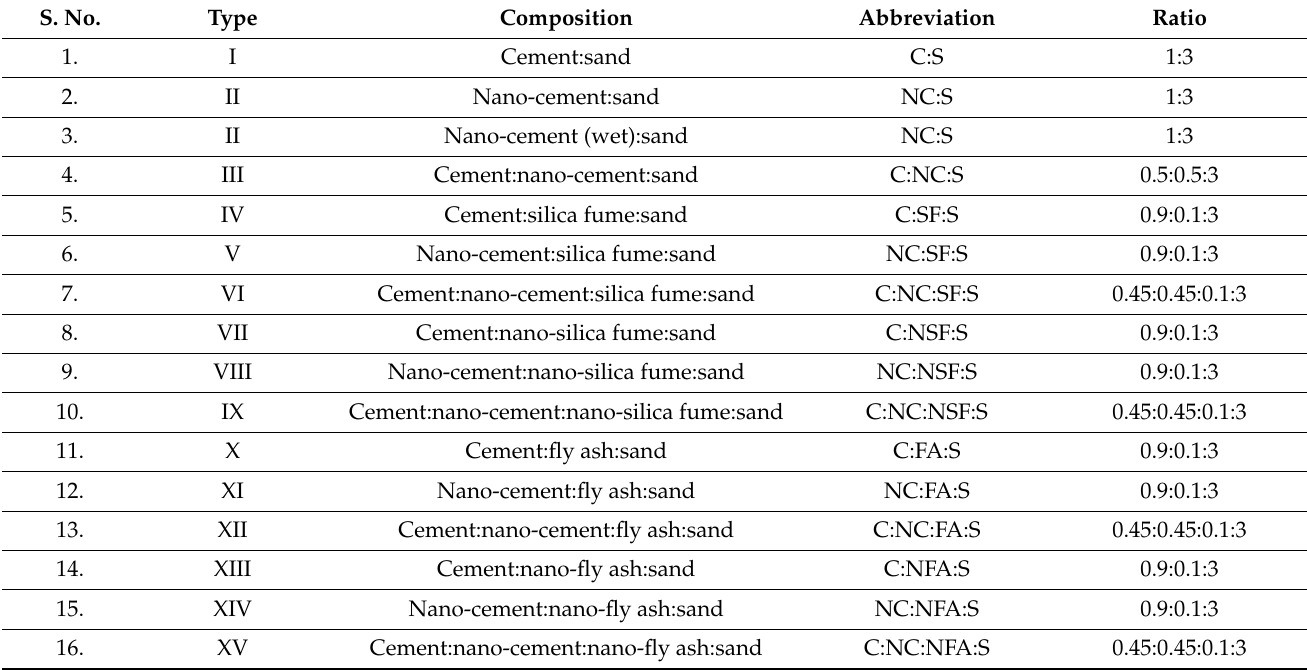
Table 7. Comparison of test results of cubes with cement (C) and nano-cement (NC) with test results of cubes with cement, nano-cement, and silica fume (SF); test results of cubes with cement, nano- cement, and nano-silica fume (NSF); test results of cubes with cement, nano-cement, and fly ash (FA); test results of cubes with cement, nano-cement, and nano-fly ash (NFA); and test results of cubes with cement.